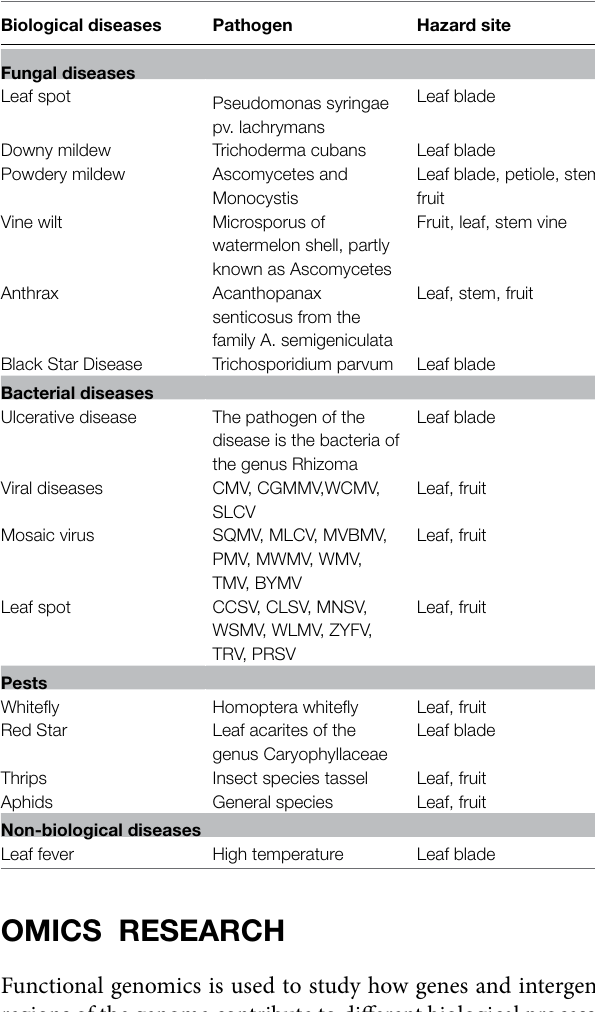
TABLE 2 | Diseases and pests in S.